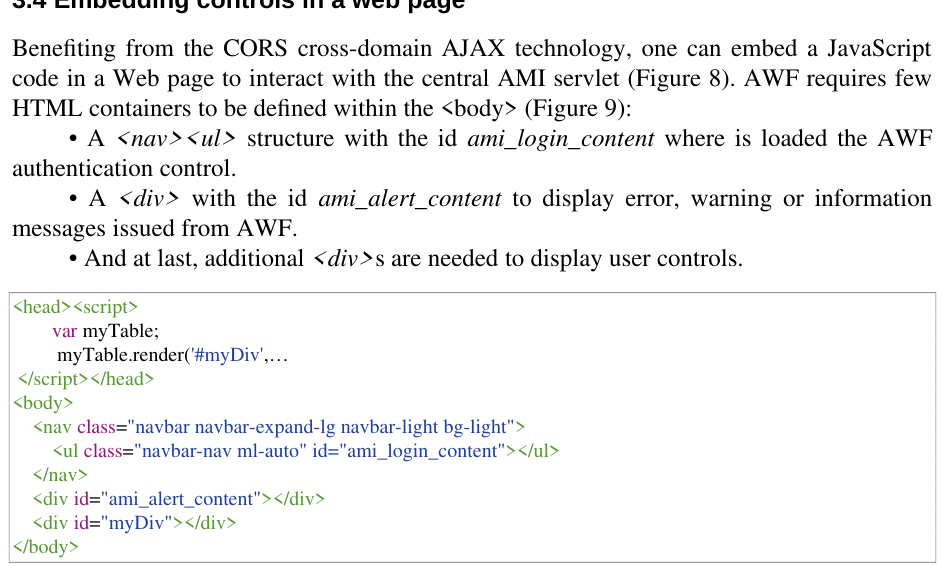
Fig. 9. Embeding AWF “table” graphical control in a Web page.